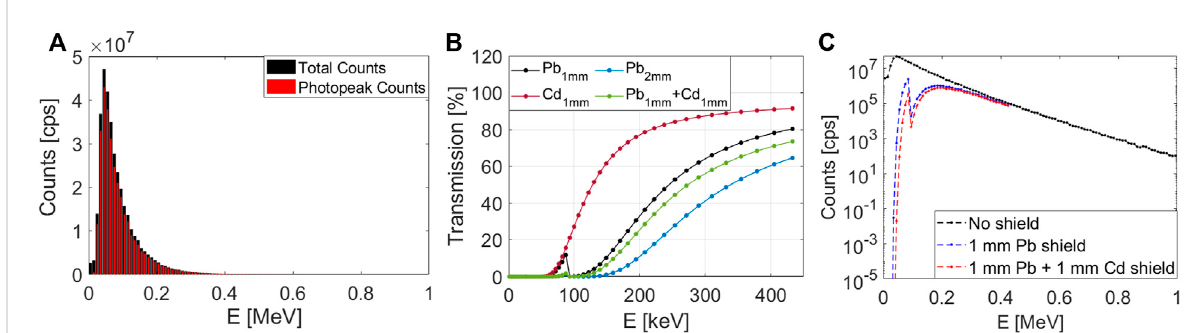
FIGURE 14 (A) Counting rate in HPGe detector array as a function of gamma-ray energy. Red area corresponds to photopeak events while the black one is associated to the total number of events hitting the array. (B) Transmission trend versus the γ -ray energy for different shield thicknesses and/or materials. (C) Shield effects on the background spectrum (log scale). The black dashed line corresponds to the rate in an unshielded array while blue and red ones show the suppression effect due to lead or lead and cadmium shields,